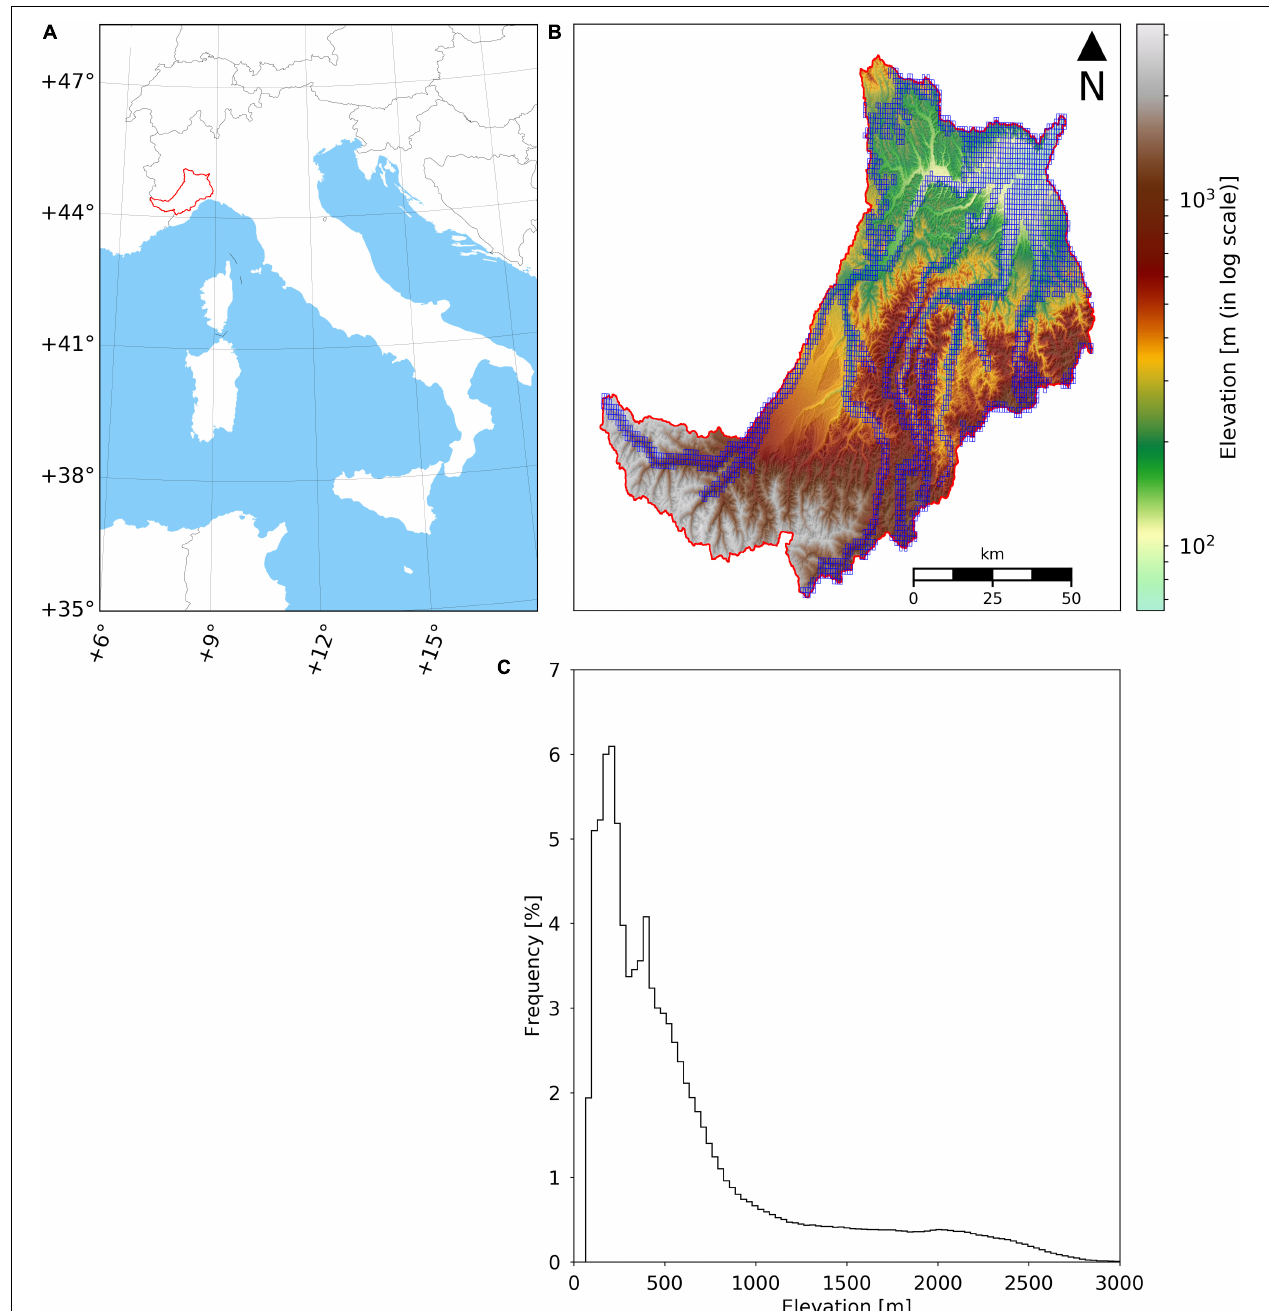
FIGURE 2 | Representation of the study area. (A) Location of the Tanaro river basin in the Piedmont region, NW Italy, with the drainage divide highlighted in red; (B) digital elevation model (DEM) of the Tanaro river basin and footprint of the light detection and ranging (LiDAR) dataset in blue; (C) histogram of elevations within the Tanaro river